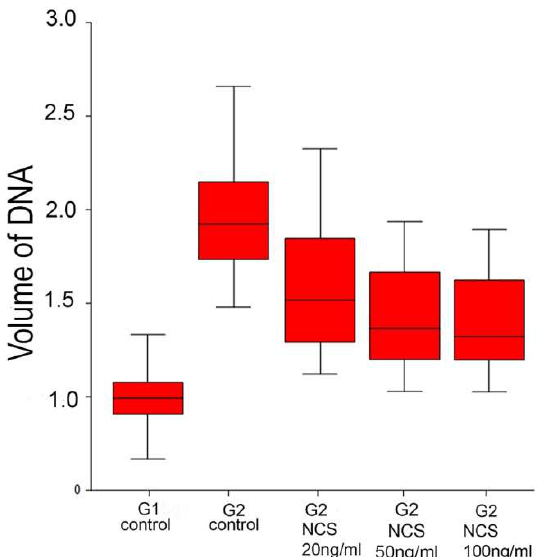
Figure 5. Propidium iodide staining of pronuclei in control (in the G1- vs.the G2-phase) and NCS-treated (in the G2-phase) one-cell embryos. The Z-projection of the confocal sections across the whole pronuclei is shown. Scale bar =10 µm.